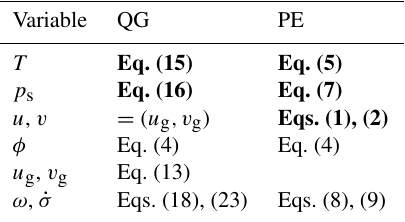
Table 1. Summary of the common approach to solve the QG and PE systems. Prognostic equations are marked in bold. In this table, u and v denote advecting wind